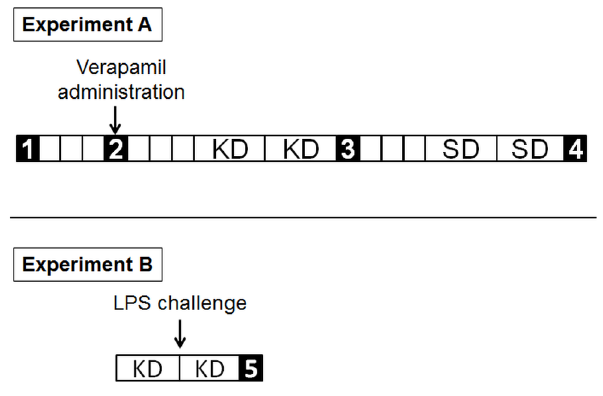
Figure 1. Experimental workflow. Each box represents a day. The numbers indicate the 18 F-FDG PET/CT scans. Experiment A: (1) baseline, (2) post-verapamil, (3) post-ketogenic diet (KD) and (4) post-sunflower seed diet (SD). Experiment B: LPS challenge was performed 24 hours before the PET scan